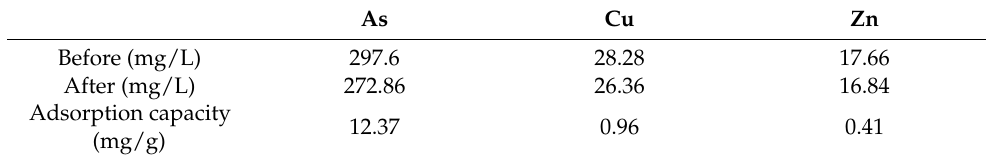
Table 4. The comparison of industrial wastewater before and after TEPA-GTS-NPSi